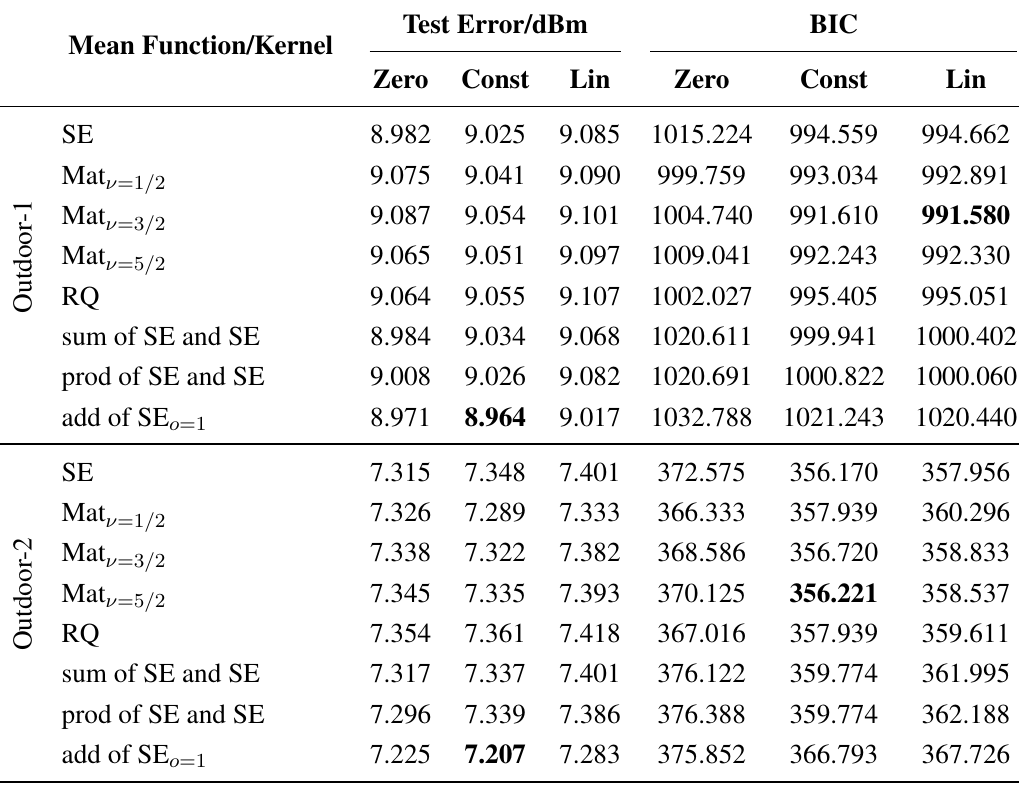
Table 3. Test error and BIC for different Gaussian process models trained with the outdoor data. The values are averages over several access points and 10-fold cross-validation. The lowest test error and BIC are